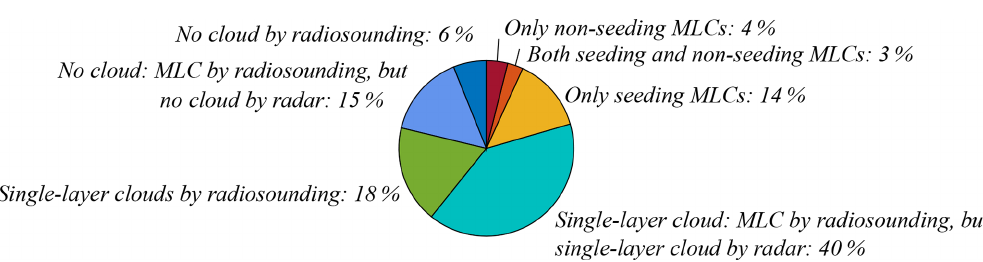
Figure A3. Cloud occurrence derived from using both radiosonde and radar for detection. For the radiosonde data the measurement un- certainty is considered to be + 5% relative humidity over the whole radiosonde profile. Seeding and non-seeding is calculated using an ice crystal of the size r = 400µm. The values are rounded to zero decimal